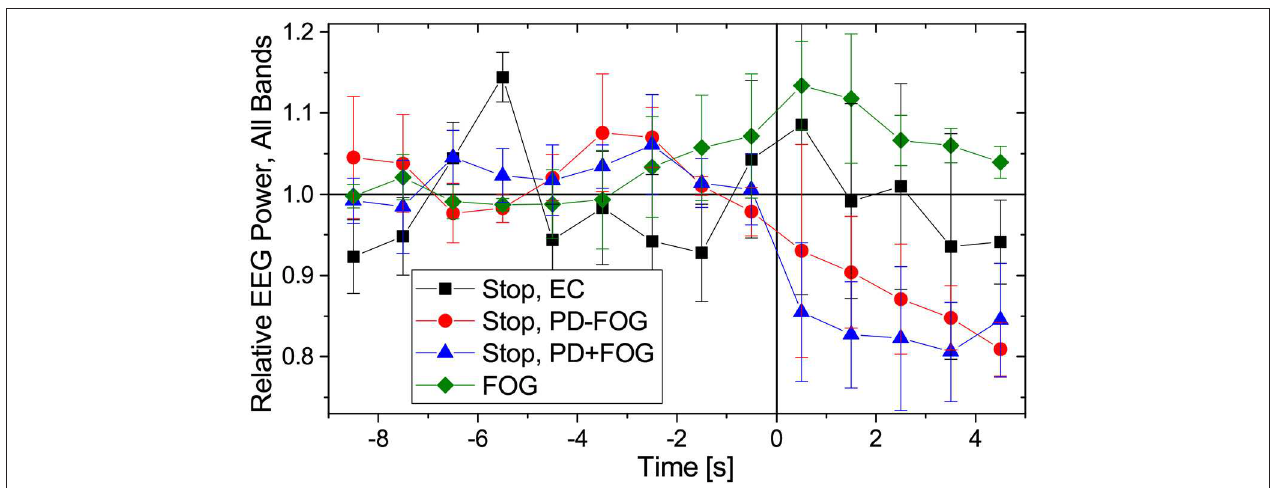
FIGURE 4 | (Color online) Relative changes of EEG amplitudes during normal walking (time: − 9 to 0 s) followed by a commanded stop or FOG event (time: 0 to + 5 s). As in Figure 2 , data have been normalized to 1 for normal walking (time from − 9 to − 5 s). We have considered the following EEG frequency bands: theta (4–7.5Hz), alpha (7.5–13Hz), low beta (13–21Hz), and high beta (21–35Hz). Since we found no difference in how EEG amplitudes change for the respective frequencies, we present here an average over all four bands. EEG data from the central electrodes (C3 and C4 closest to the motor cortex) were used; results for other EEG electrodes are similar. Error bars indicate the standard deviations of the relative EEG powers across the four considered bands. As in Figure 2 , points to the left of the vertical line are not affected by data recorded after time